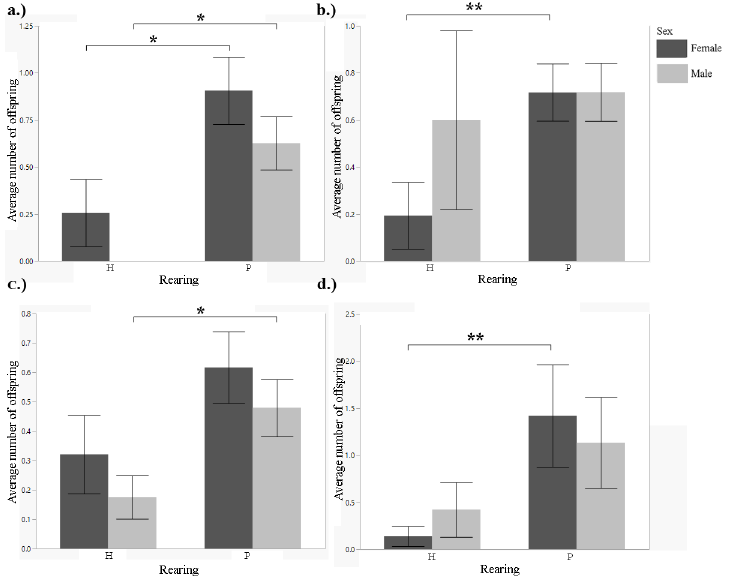
t-test: * p < 0.05; ** p < 0.01.